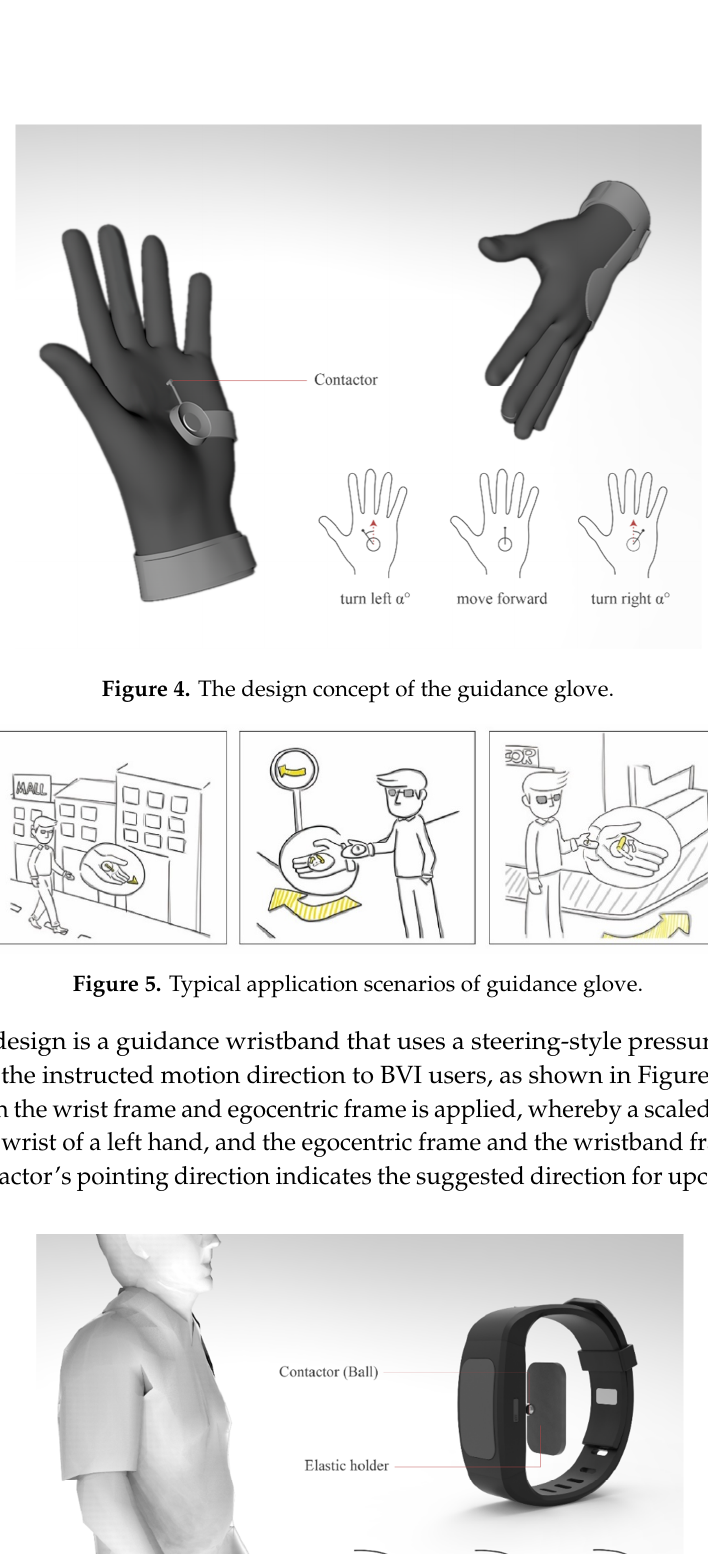
Figure 6. The design concept of the guidance wristband.